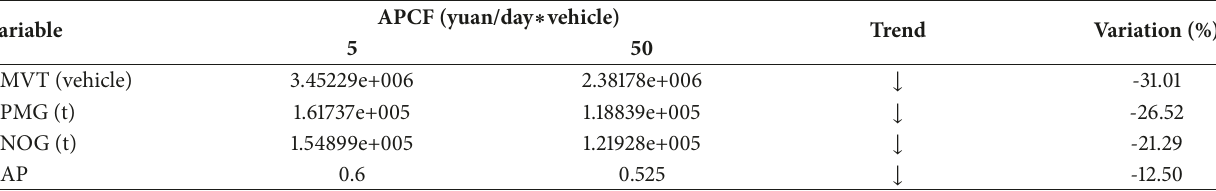
Figure 5: Development trends of the change rates of the main variables. (a) AMVT. (b) APMG. (c) ANOG. (d) Trend comparison. Table 10: The comparison of different